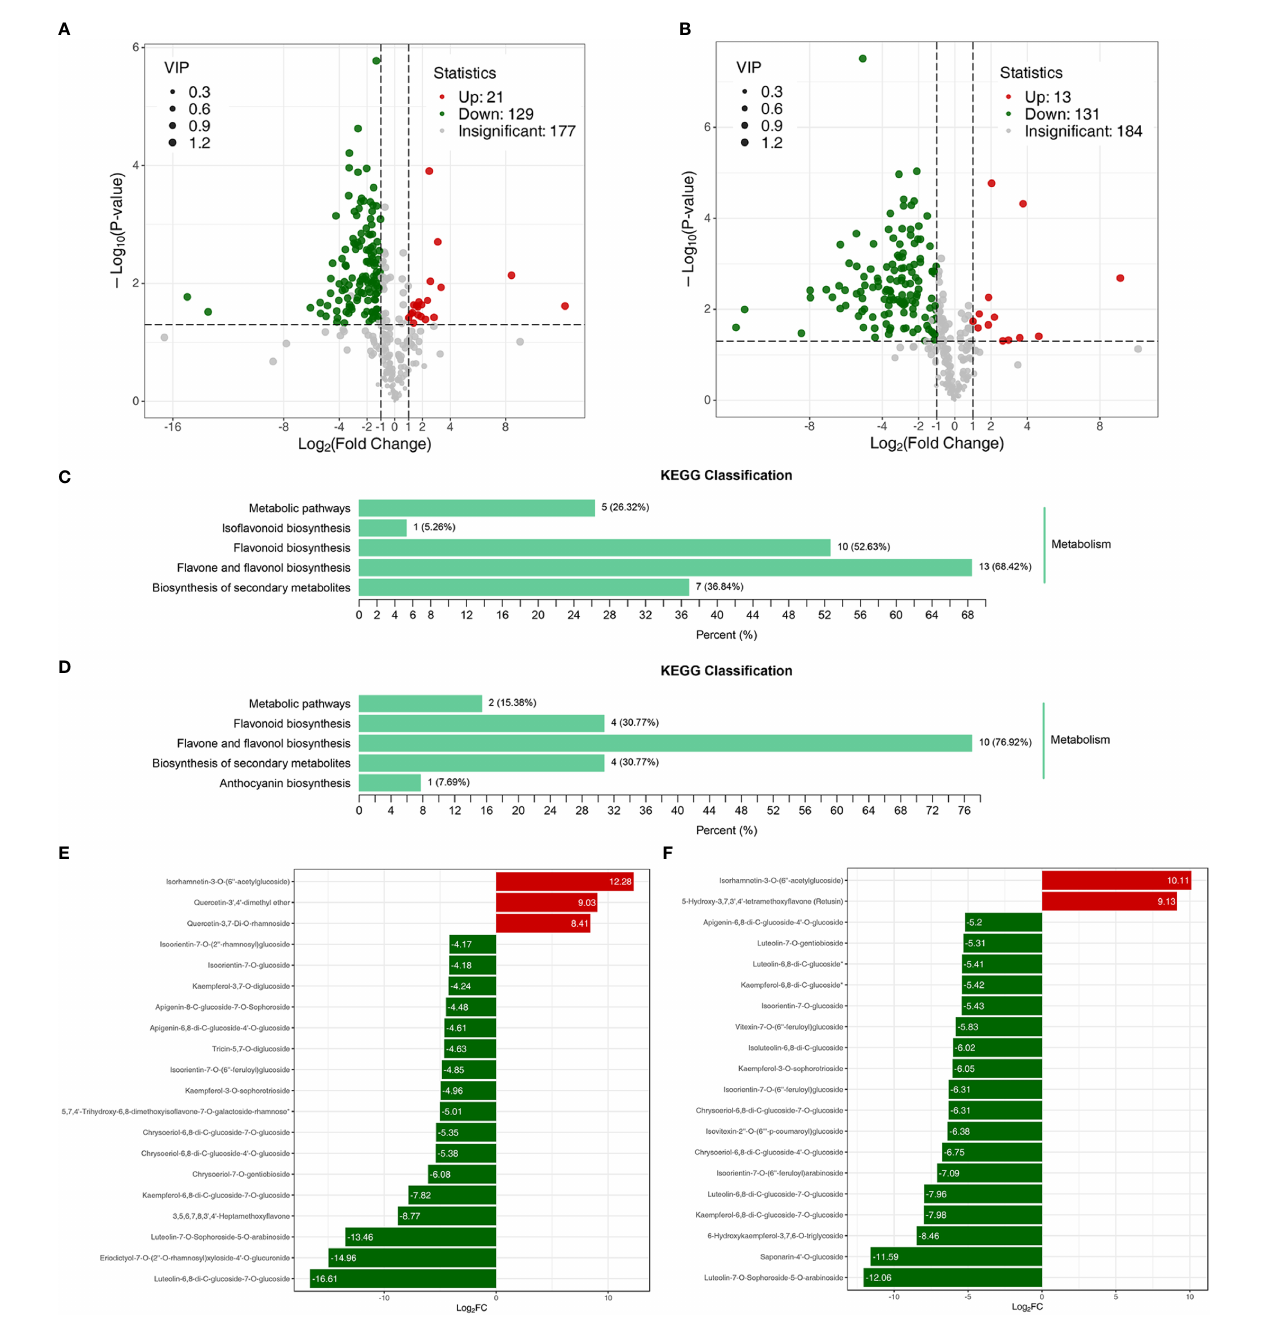
FIGURE 2 DAF analyses of wheat cv. Jimai229 and HHG46 with vs without powdery mildew inoculation. Volcano plots indicating DAFs in (A) JM229-0/JM229-pm and (B) HHG46-0/HHG46-pm. KEGG classi fi cation analysis of the DAFs from (C) JM229-0/JM229-pm and (D) HHG46-0/HHG46-pm. The top 20 DAFs from (E) JM229-0/JM229-pm and (F) HHG46-0/HHG46-pm. Red, upregulated DAFs; green, downregulated DAFs. DAF, differentially accumulated fl avonoids; KEGG, Kyoto Encyclopedia of Genes and